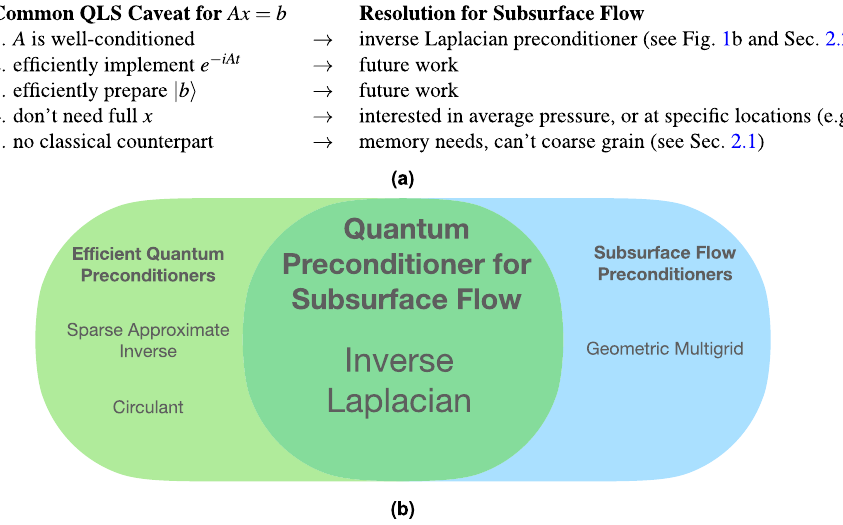
Figure 1. Summary of results. ( a ) Common requirements for good performance from QLS algorithms, and the ways in which subsurface flow problems can be made to meet them. Our primary contributions in this work are points 1 and 5, namely, introducing the inverse Laplacian preconditioner and providing arguments against the scalabality of classical methods. ( b ) Existing quantum preconditioners are not effective on subsurface flow through fracture systems, while classical fracture preconditioning techniques cannot reasonably be enacted via quantum algorithms. The inverse Laplacian is well-suited to fracture systems while also being efficiently realized on a quantum